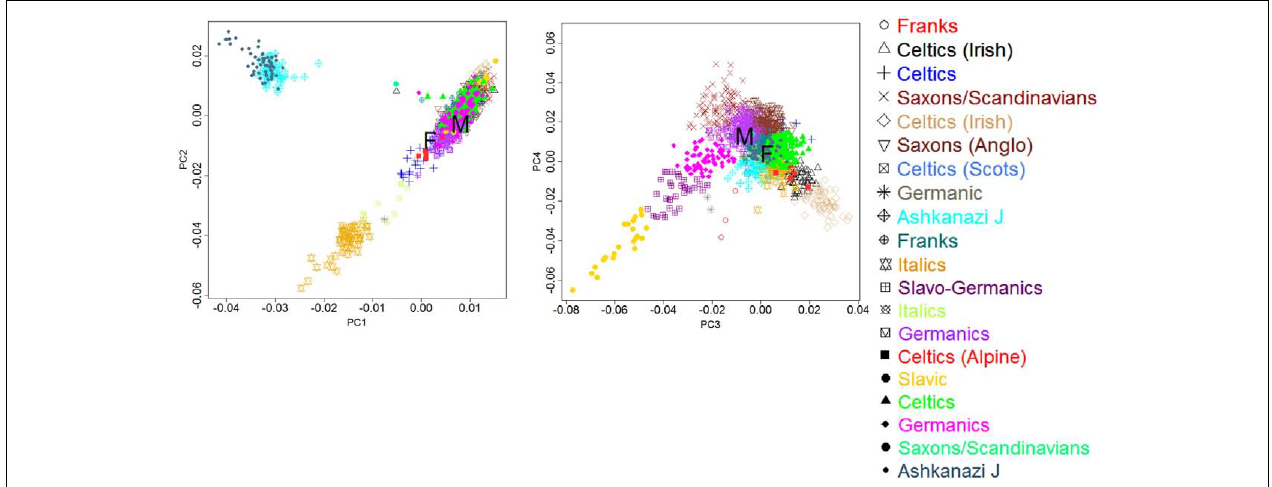
an algorithm described in Solovieff et al. (2010).The clusters were then labeled by ethnicity using the information about mother tongue and place of birth of NECS subjects and their parents. Based on the coordinates of the PCs of two subjects in the plots, we confirmed that the female had a mixed French/British ancestry, while the males had mainly a Germanic ancestry.